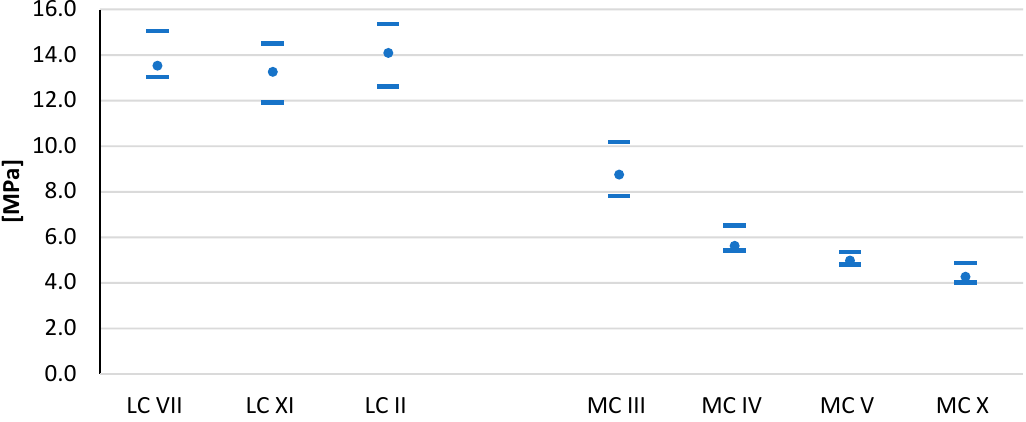
Figure 7. Compressive strength of the CSRE sample series with 9% cement content. Horizontal lines mark the minimum and maximum value in the sample series, while the round points mean the average value.